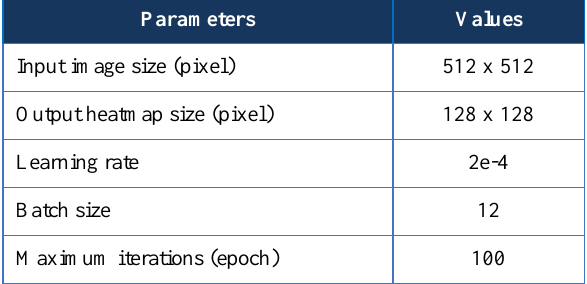
Table 2. Settings of hyper-parameters